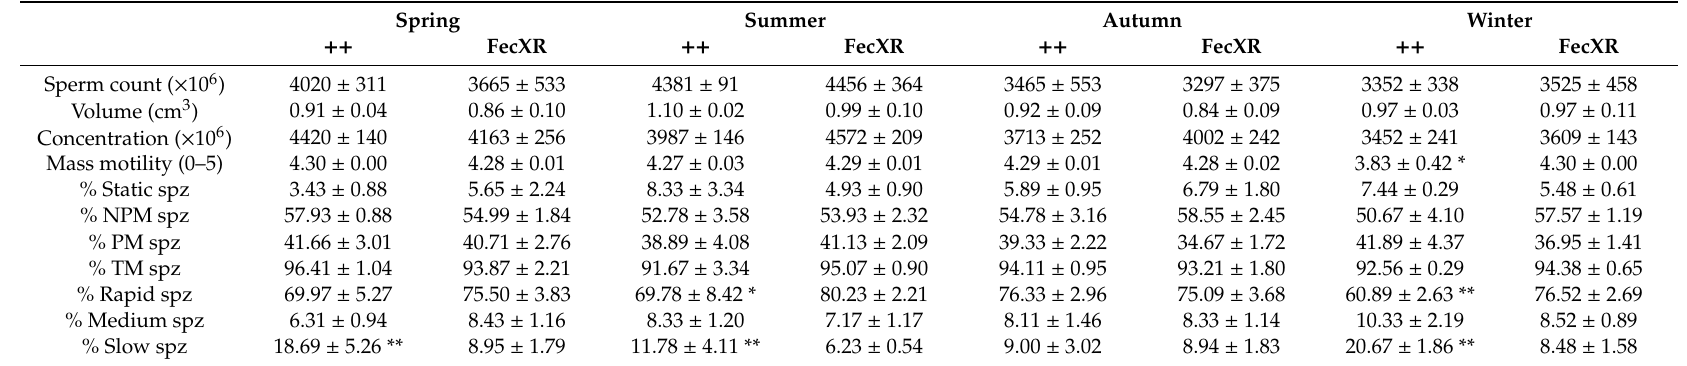
Table 1. Seminal traits (mean ± S.E.M.) of Rasa Aragonesa rams of the wild genotype ( ++ ; n = 5) or carrying the FecXR allele of the BMP15 gene ( n = 10) (* indicate di ff erences p < 0.10 within season) (** indicate significant di ff erences at p < 0.05 within season). Values calculated from semen samples collected twice a week for